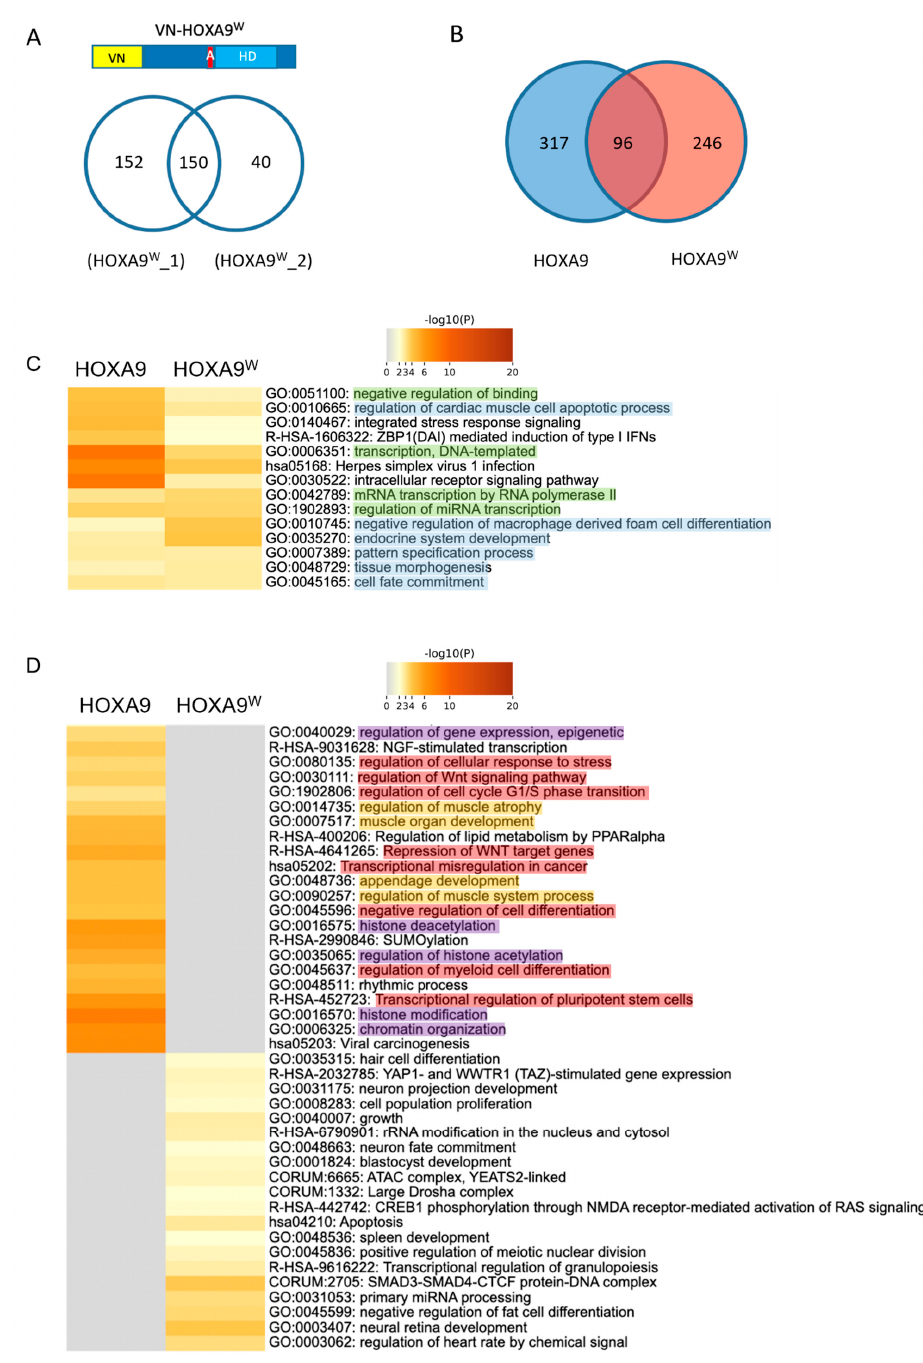
Figure 3. Cell-PCA revealed distinct interactomes of HOXA9 and HOXA9 W . ( A ) Venn diagram of HOXA9 W -interacting ORFs in the two CC-HEK cell lines. The Trp (W) mutation into an Ala (A) is shown in the schematized VN-HOXA9 W protein above the Venn diagram. ( B ) Venn diagram showing the comparison of HOXA9 and HOXA9 W interactomes. ( C ) Heatmap of the top-20 enriched biological functions in both HOXA9 and HOXA9 W interactomes. One row per function, using a discrete color scale to represent statistical significance (from high (dark red) to no (gray) significance). Blue and green colors highlight functions involved in transcriptional regulation or morphogenesis, re- spectively. ( D ) Heatmap showing the specific biological functions underlying HOXA9 and HOXA9 W interactomes (considering the 317 HOXA9-specific and 246 HOXA9 W -specific interactions). Violet, orange and red colors, respectively, highlight functions involved in epigenetics, muscle formation and cell proliferation/cancer, which were lost upon the W